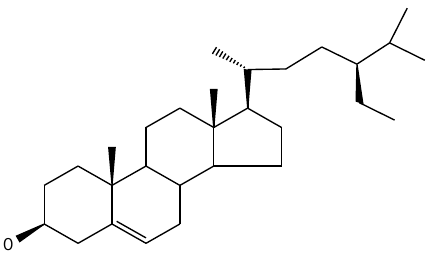
Figure 2. Chemical structure of β-sitosterol from the InH compound.